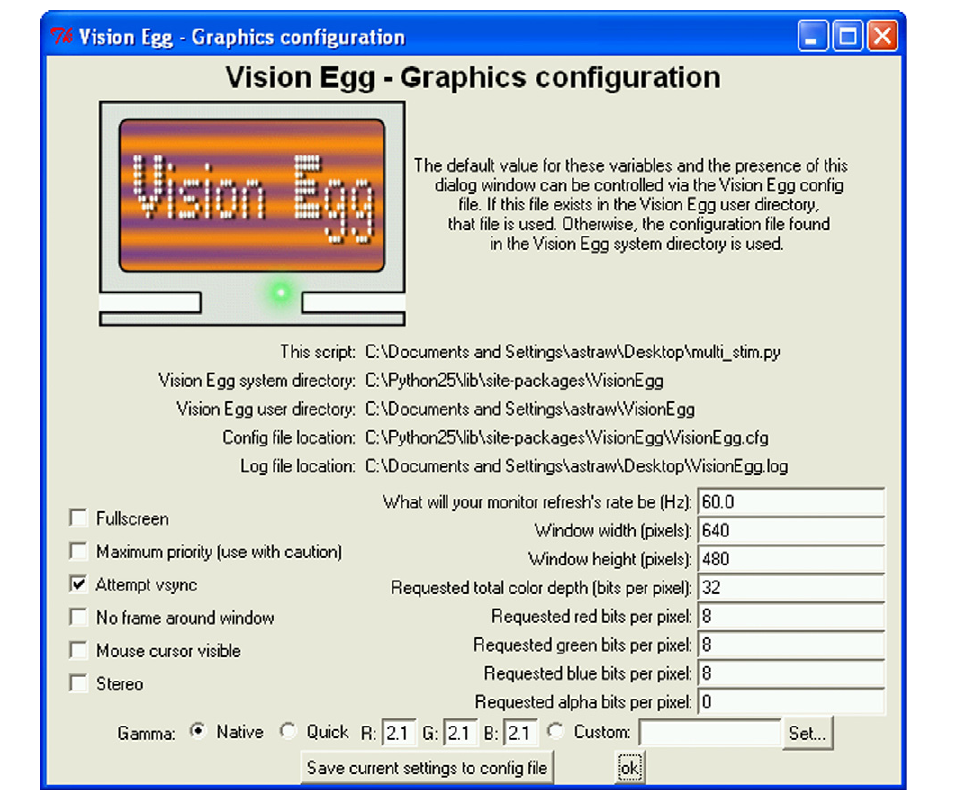
Figure 3 | Screenshot of the standard Vision Egg confi guration GUI. Numerous options for confi guration are available, including framebuffer size and bit depth, color lookup tables for gamma correction and platform-dependent realtime priority, as described in Section “High-level Software Overview: Specifying Graphics